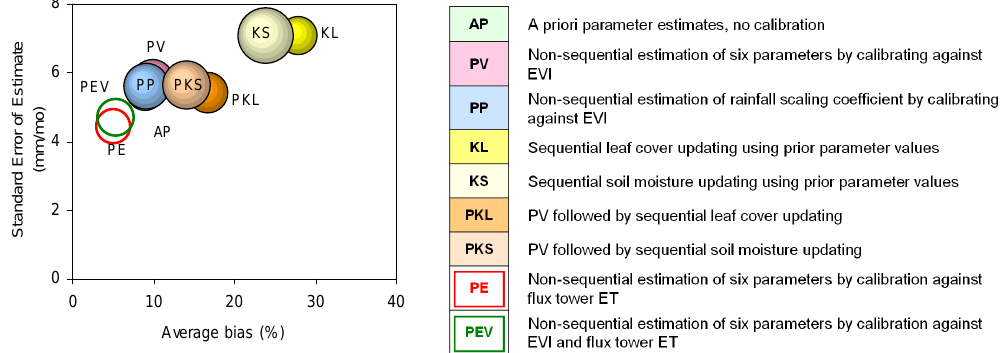
Fig. 6. Indicators of estimation uncertainty for alternative model-data fusion approaches for flux tower ET (the area of the circles is propor- tional to the unexplained variance, varying between 11–17%). The most desirable result would show a small circle in lower left corner. Note that the absolute value of bias for each site was calculated before